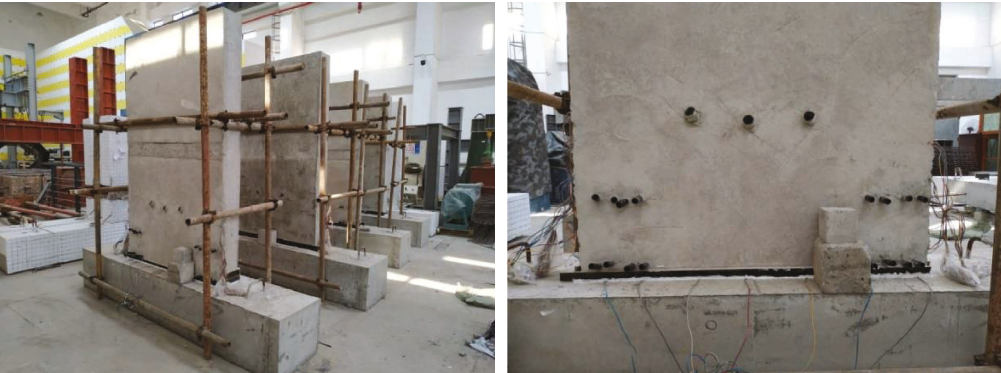
Figure 2: Aassembly process of precast shear